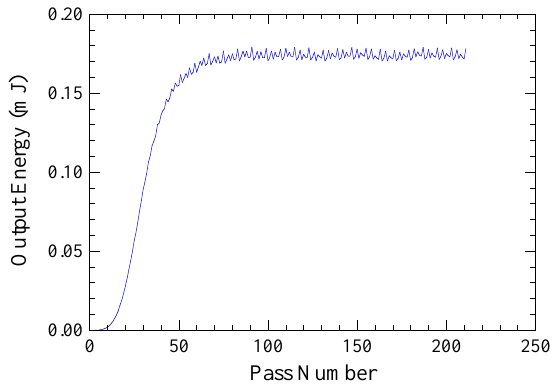
Figure 6. Simulated pulse energy as a function of roundtrip number n at a near optimal cavity detuning of L cav = 8.01049 m for the IR Demo experiment. Remaining parameters as described in the text.